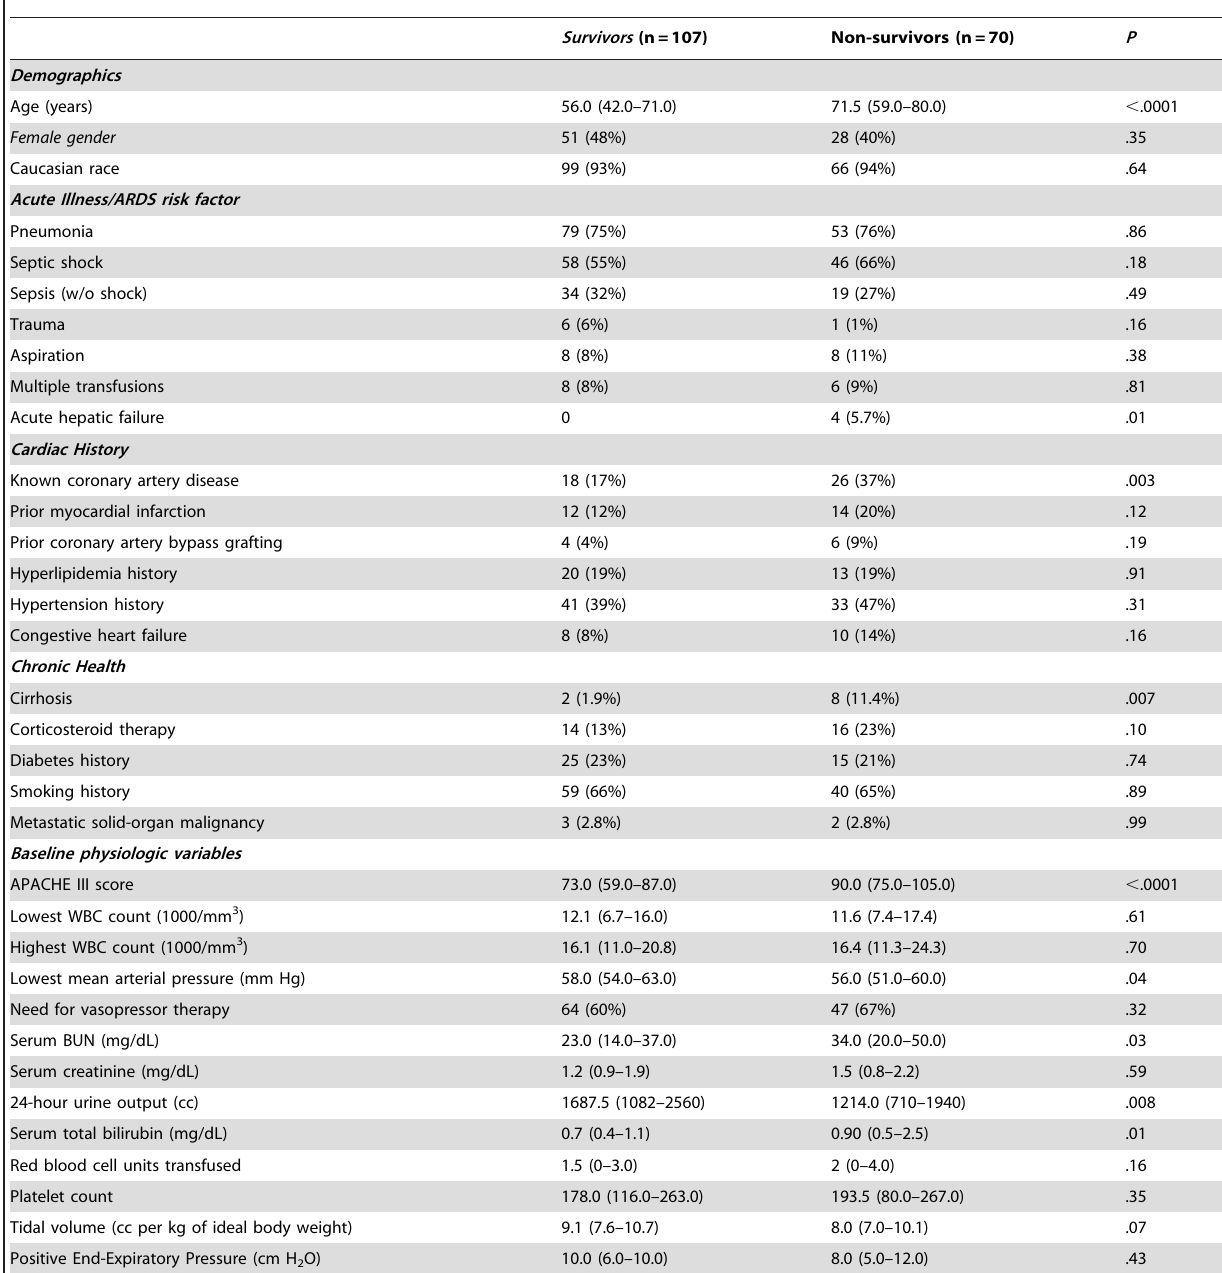
Table 1. Baseline Characteristics of Study